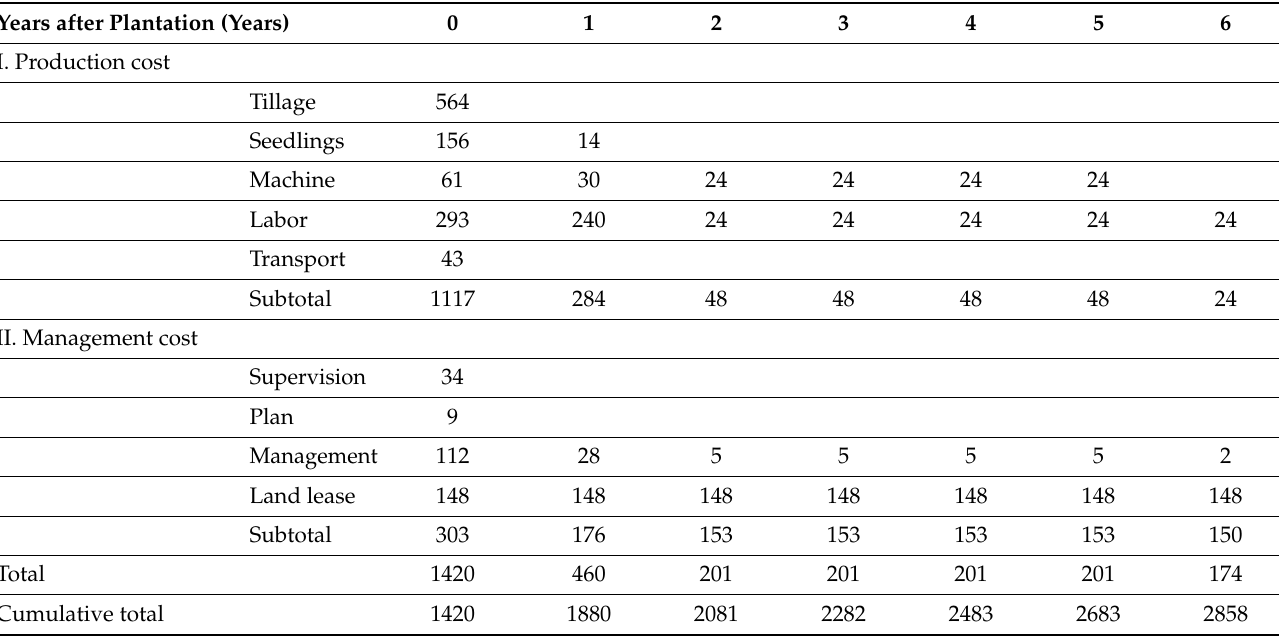
Table 1. Annual costs per ha of production and management parts (unit: USD ha − 1 ).